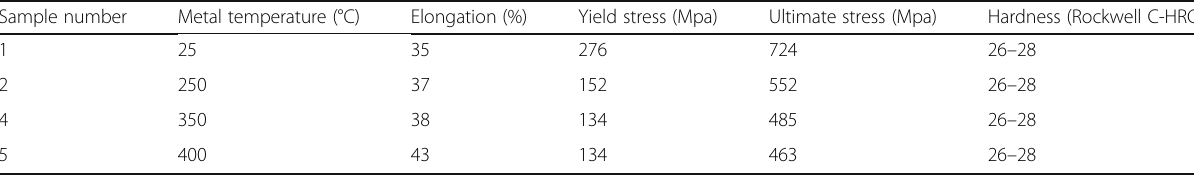
Table 6 Results of the tensile test Sample